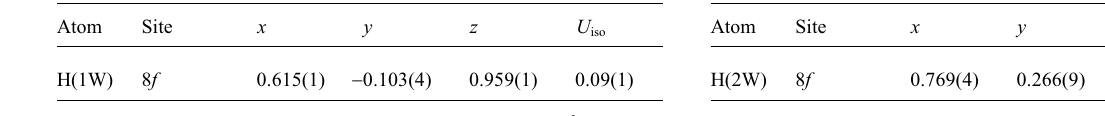
Table 3. Atomic coordinates and displacement parameters (in Å 2 )